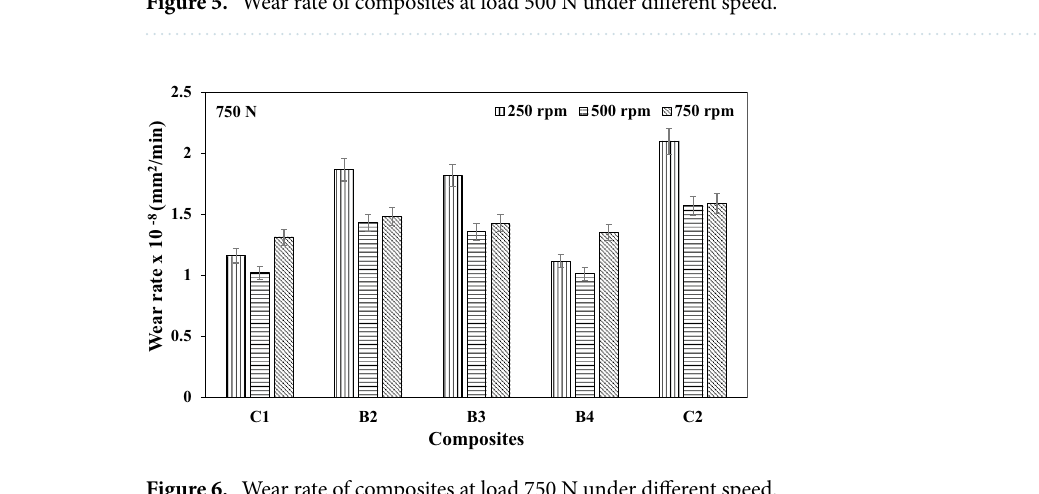
Figure 5. Wear rate of composites at load 500 N under different speed.